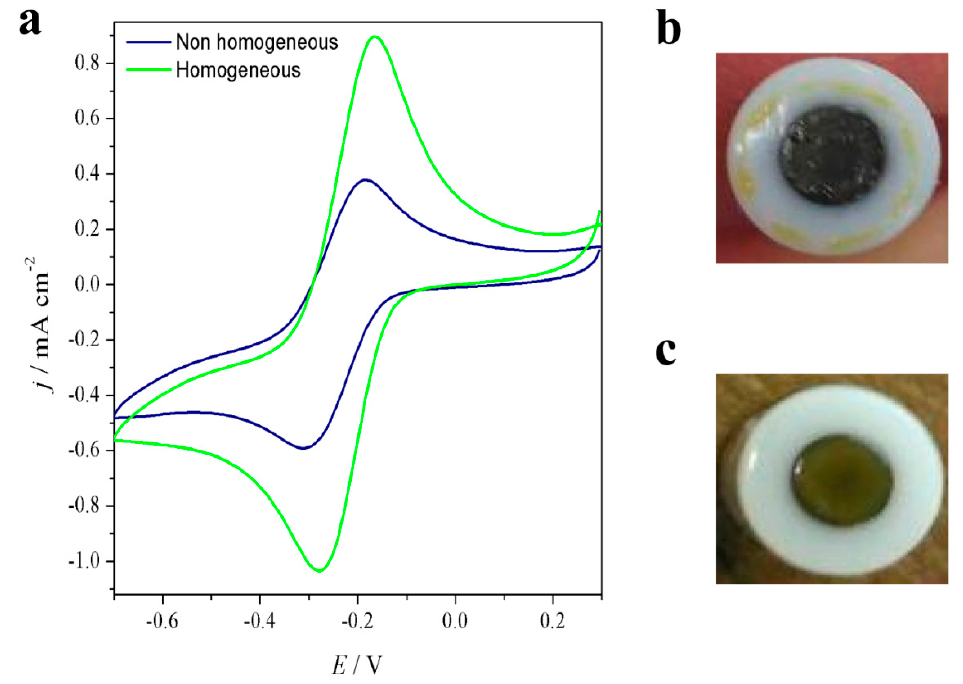
Figure 6. ( a ) Cyclic voltammograms of PEDOT_SPAES_1 (i) homogeneous casting conditions: 50 °C, 250 mbar, 140 min of drying, and (ii) non homogeneous casting conditions: 50 °C, 250 mbar, 390 min; ( b ) non-homogenous PEDOT_SPAES_1; and ( c ) homogeneous PEDOT_SPAES_1. The electrochemical probe is 3 mM [Ru(NH 3 ) 6 ]Cl 3 .